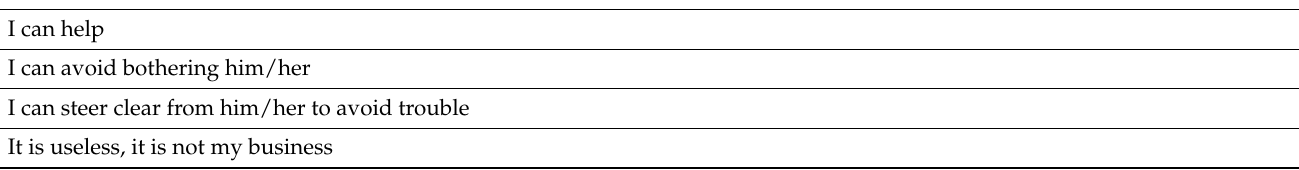
Table A1. Questions and pre-coded responses on prosocial tendency among children.